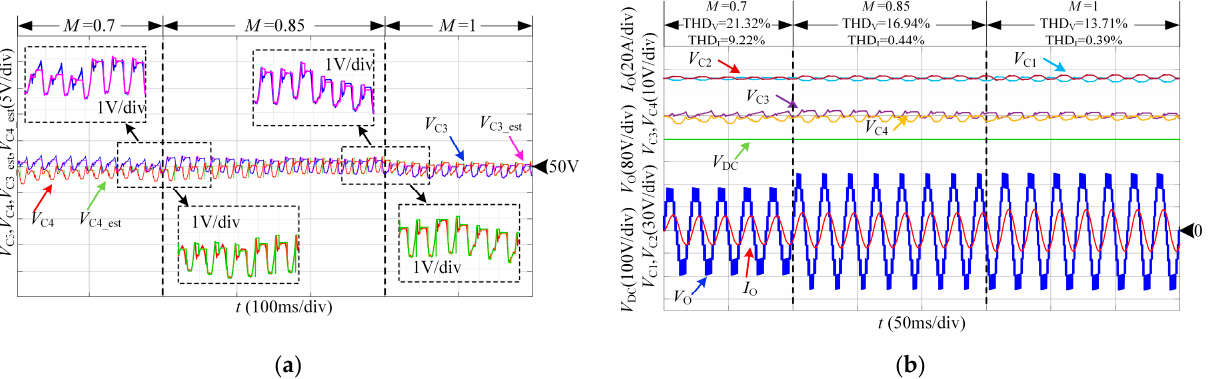
Figure 11. Simulation waveforms of the proposed floating capacitor voltage sensorless control scheme. ( a ) Simulation waveform of actual and estimated value of floating capacitor voltage; ( b ) Capacitor voltage, output voltage and output current simulation waveforms.